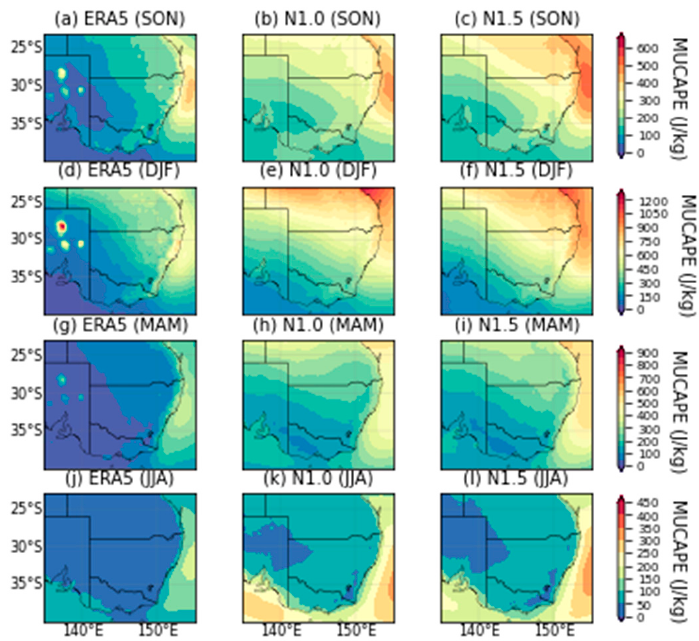
Figure A15. Climatology of MUCAPE in d02 from ( a , d , g , j ) ERA5, ( b , e , h , k ) N1.0 and ( c , f , i , l ) N1.5 during SON (row 1), DJF (row 2), MAM (row 3) and JJA (row 4). Unit: J kg − 1 .